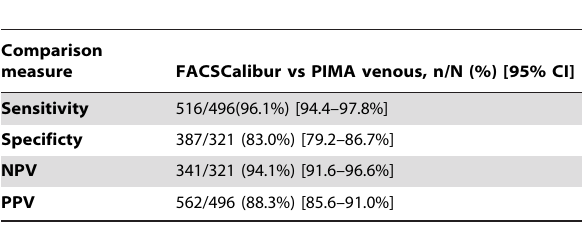
Table 6. Sensitivity, Specificity, NPV and PPV at 500 cells/uL ART eligibility threshold.